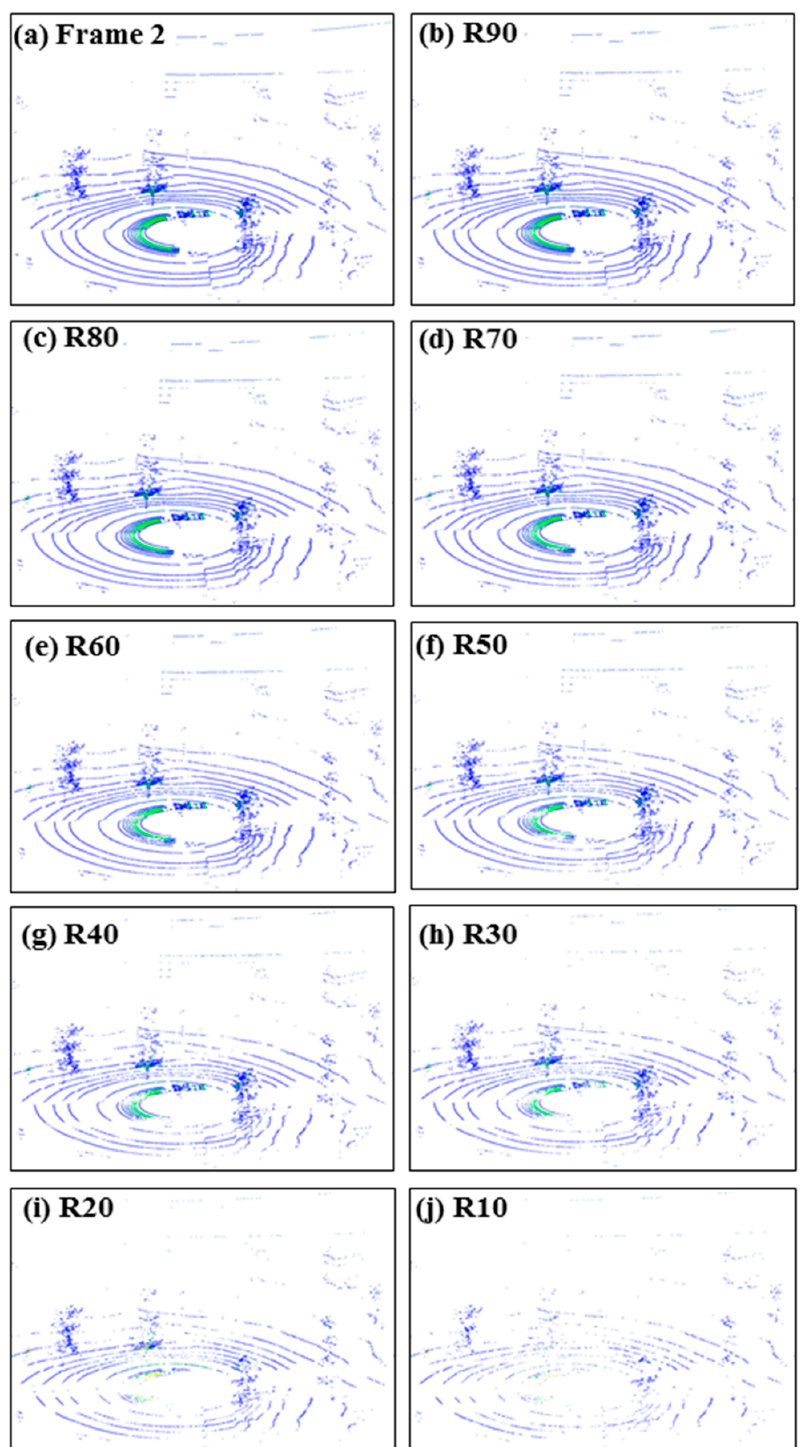
Figure 8. MLS data ( a ) original Frame 2; ( b ) 90% of points after reduction; ( c ) 80% of points after reduction; ( d ) 70% of points after reduction; ( e ) 60% of points after reduction; ( f ) 50% of points after reduction; ( g ) 40% of points after reduction; ( h ) 30% of points after reduction; ( i ) 20% of points after reduction; ( j ) 10% of points after reduction. The original dataset for Frame 2 and obtained datasets after OptD-single-MLS reduction are characterized in Table 2.